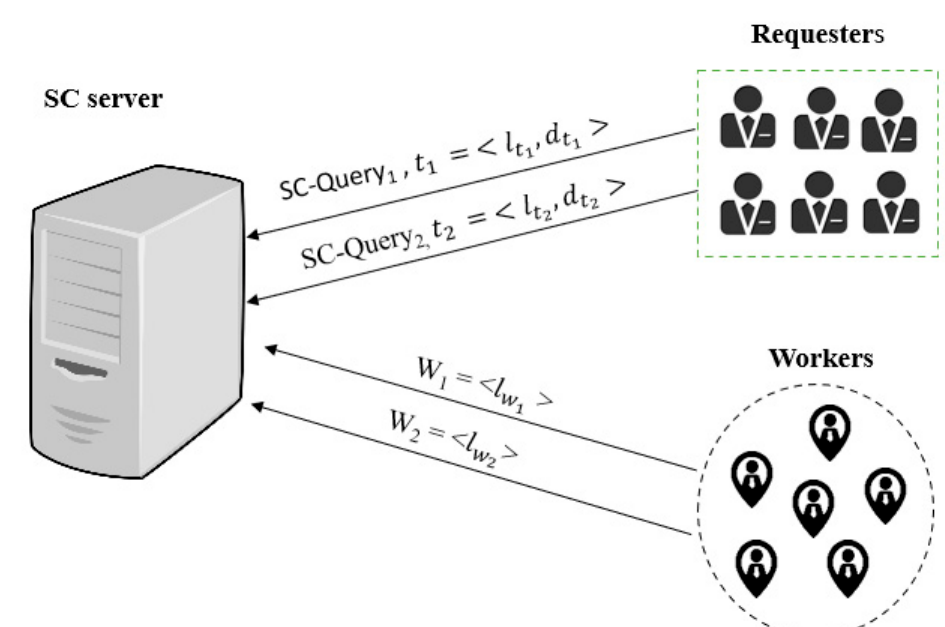
Figure 2. A spatial crowdsourcing (SC) scenario of the multi-objective task scheduling optimization (MOTSO) model.